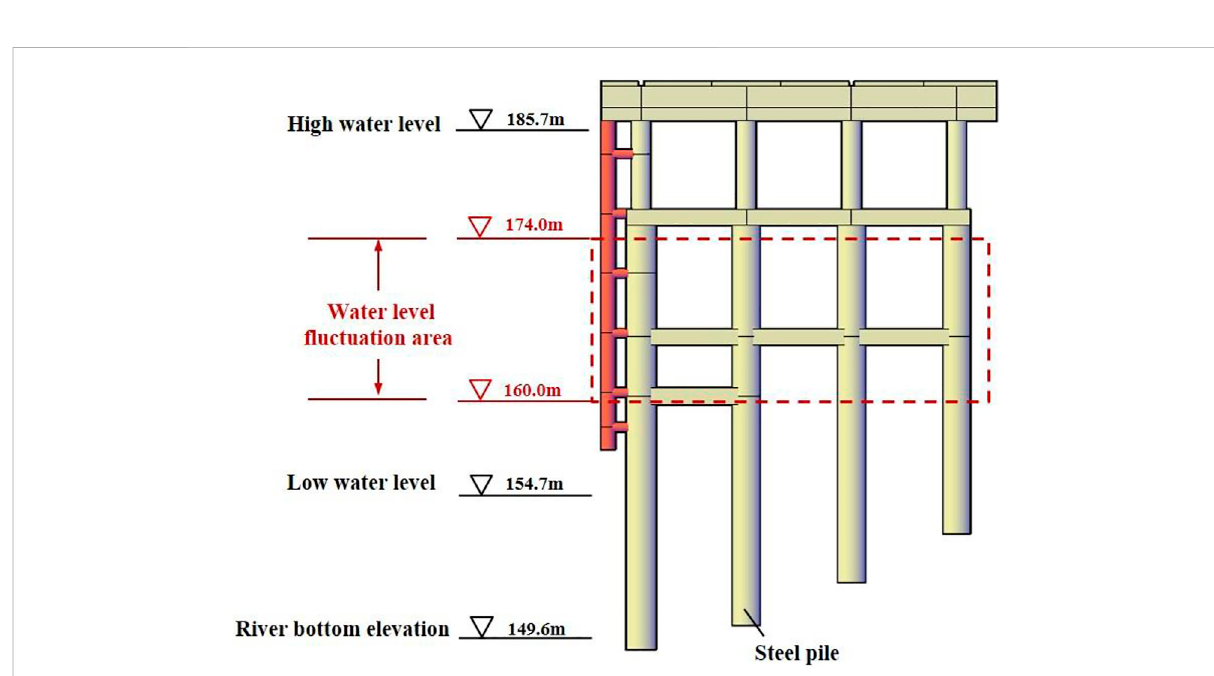
Figure 1. Exposed steel substrates are prone to periodic erosion, which located in the water level fl uctuation area (Figure